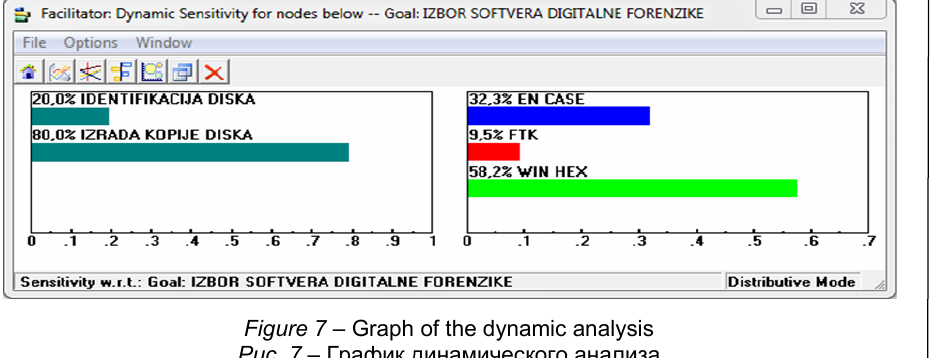
Figure 7 – Graph of the dynamic analysis Рис . 7 – График динамического